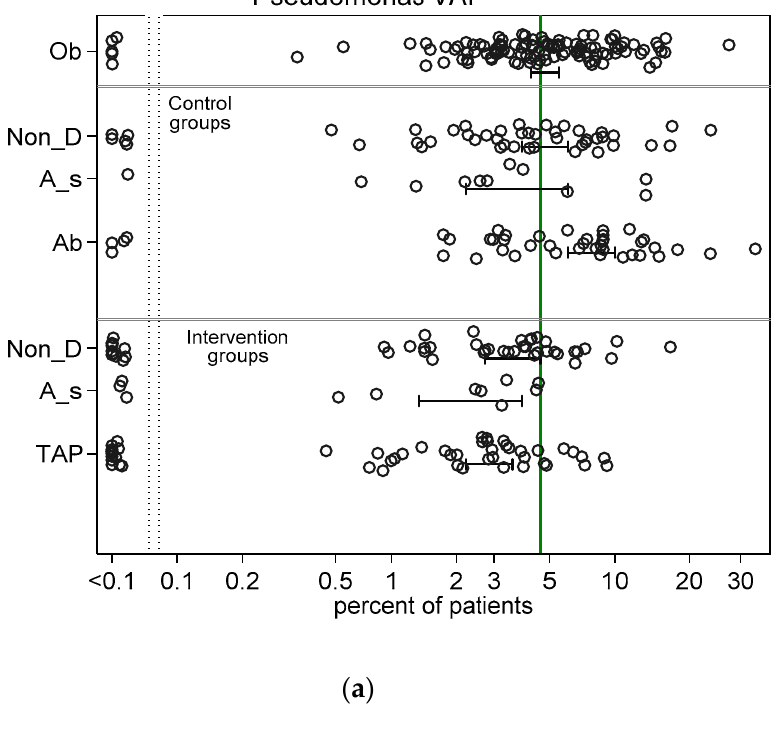
Figure 2. Scatter plots (logit scale) and 95% CI of RT Candida incidence ( a ) and Candidemia ( b ) in component (control and intervention) groups of various methods of infection prevention in the ICU, excluding studies with ICU-LOS < 5 days (ESM Figure S2a,b show including studies with ICU-LOS < 5 days). The benchmark incidence in each plot is the summary mean derived from the observation studies (central vertical line). The groups wide presence of candidemia risk factors (CRF) is identified by solid symbols versus not (open). Abbreviations; Ob = observational; non-D is non-decontamination; A_s is anti-septic; Ab is antibiotic control group; TAP is topical antibiotic prophylaxis and AF is anti-fungal.